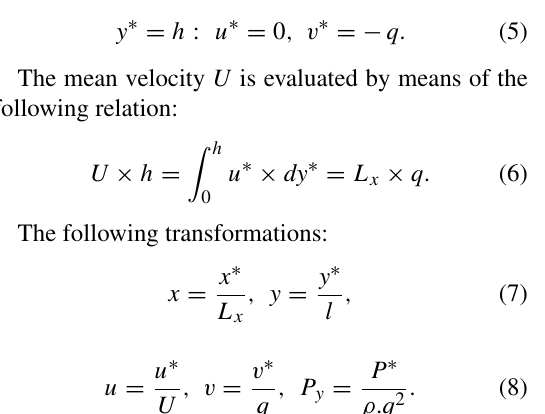
Fig. 1. Schematic diagram of the